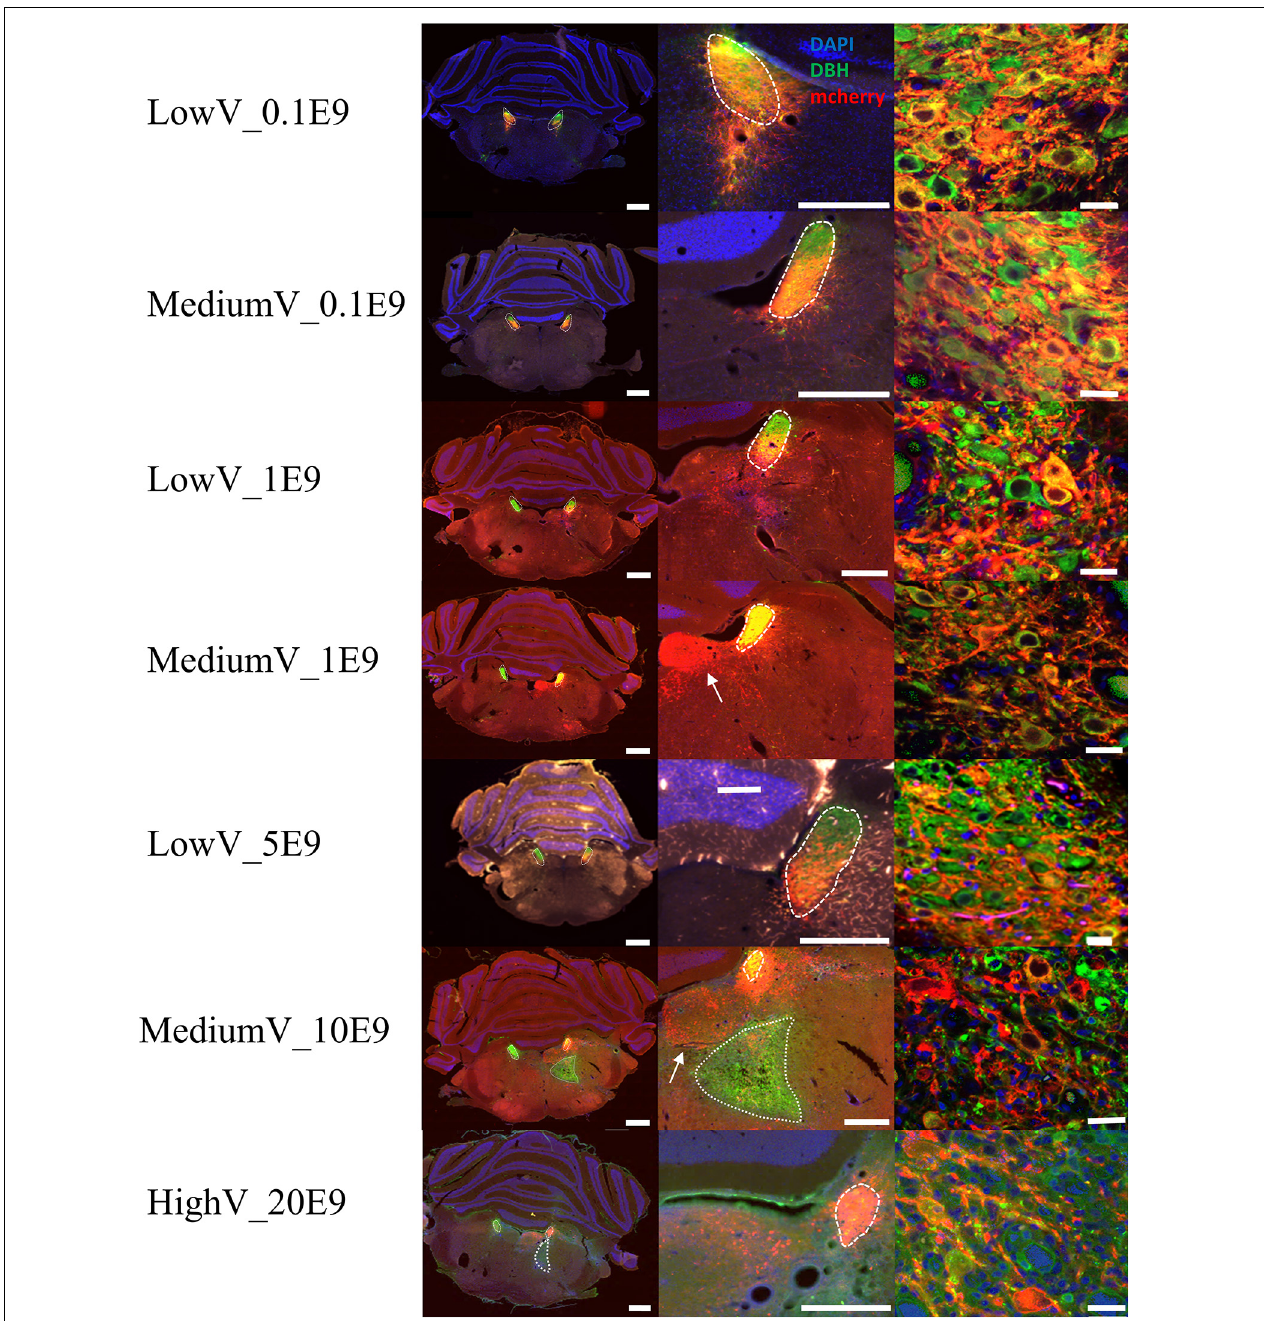
FIGURE 1 | Representative visualization of hM3Dq expression pattern in LC after injection of CAV2-PRSx8-hM3Dq-mCherry in LC for each condition. Each row represents a condition. The first column represents an overview of an LC containing tissue section; the second column shows a more detailed view of hM3Dq expression in the region of LC. The last column shows a confocal image of DBH + /hM3Dq + cells. LC is encircled with a dashed line. Aspecific hM3Dq expression is indicated by a white arrow. Ectopic DBH expression is indicated by the dotted line. LC-NA neurons and projections are visualized using primary anti-DBH antibody (green, AF 488 nm) and expression of hM3Dq DREADD is visualized using anti-RFP (red, AF 594 nm), cell nuclei are stained with DAPI (blue). Scale bar is represented at each image, left column 1,000 µ m, middle column 500 µ m and right column 25 µ m.